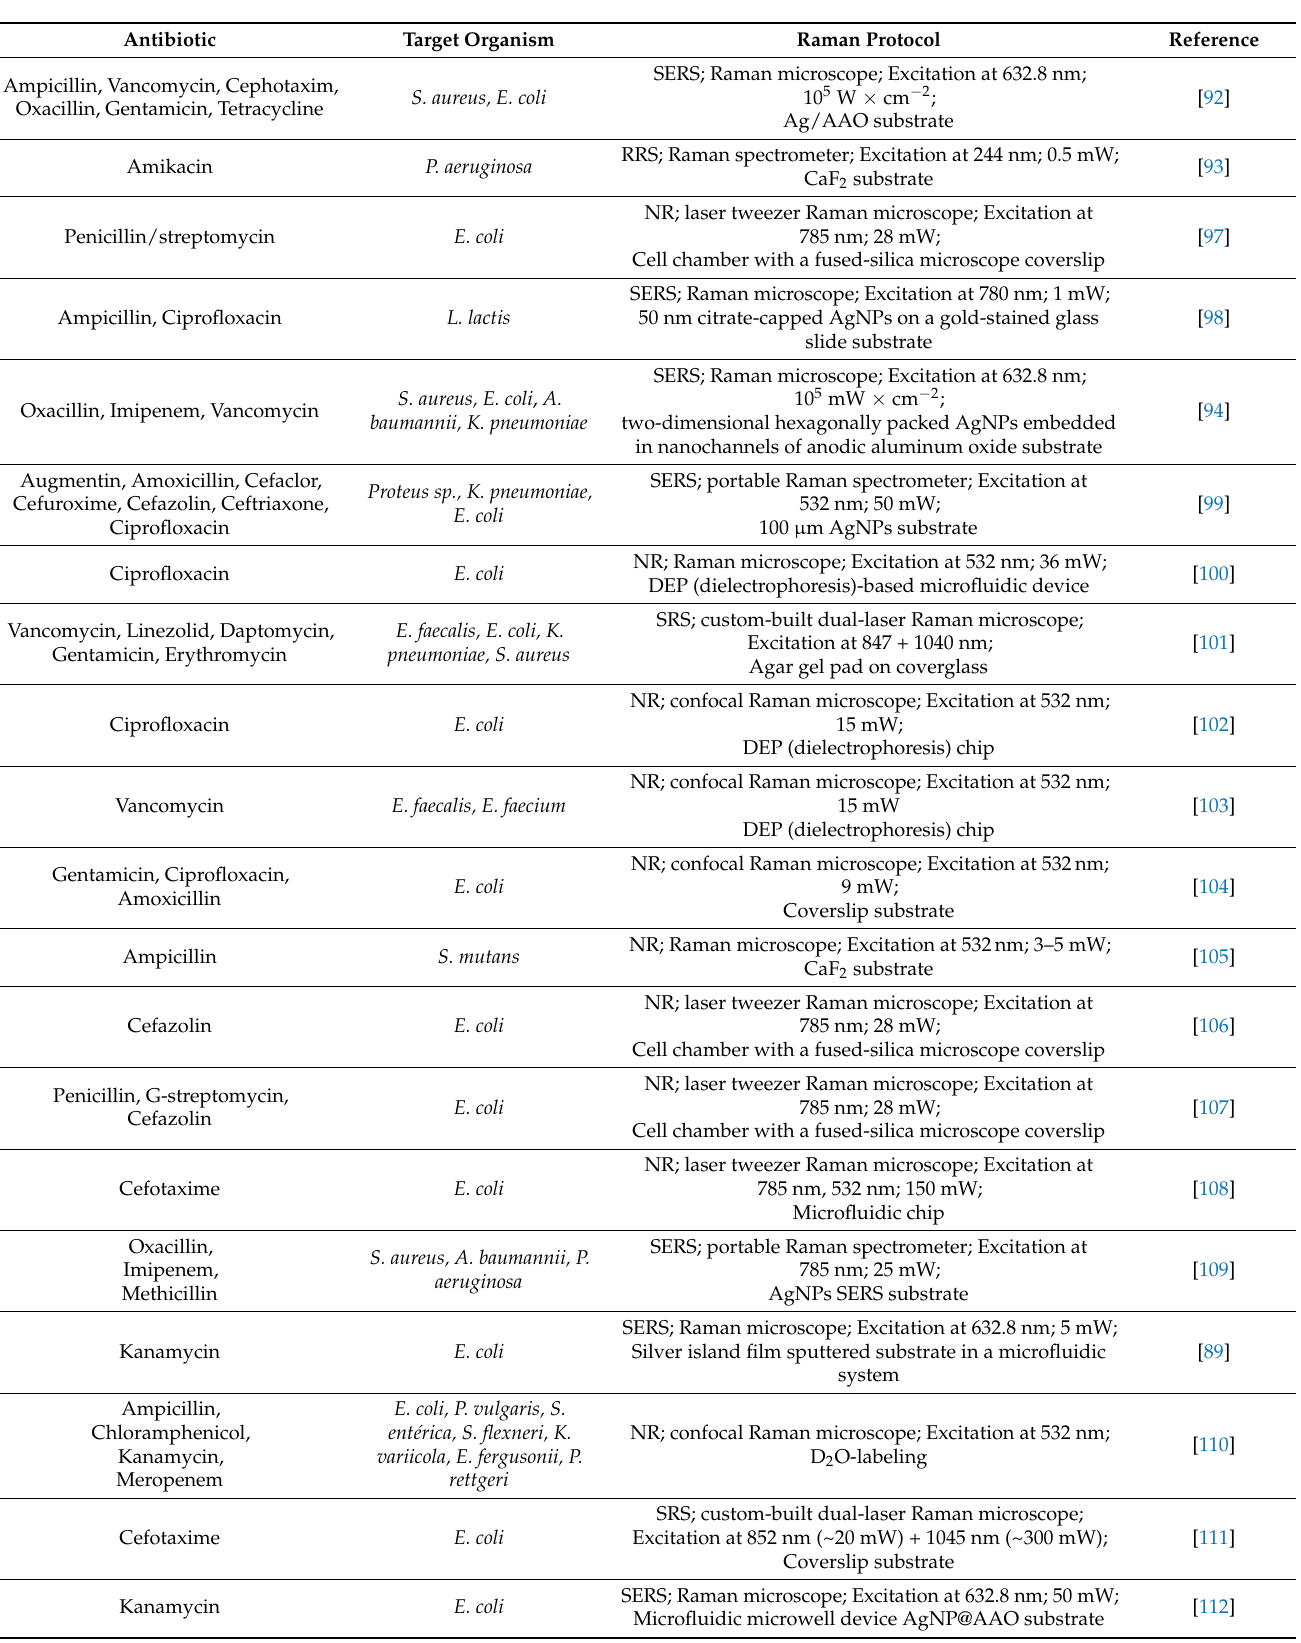
Table 2. Antibiotic susceptibility studied by Raman